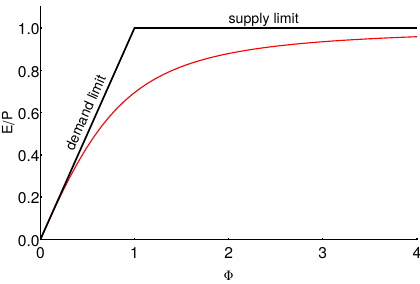
Figure 1. The original Budyko (1958) curve (red), limited by both the demand limit ( E = E p ) and the supply limit ( E = P